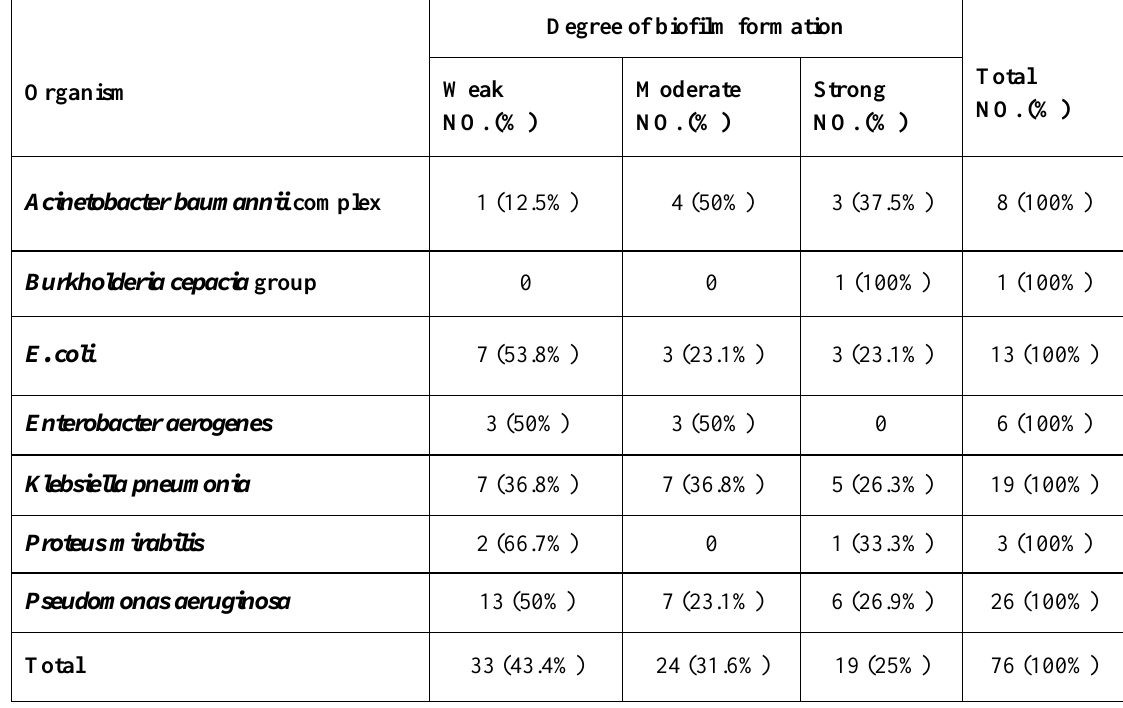
Table 1. Strength of biofilm-production in different bacterial species